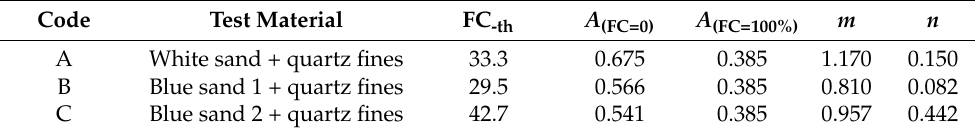
Figure 11. The relationship between the tested G max and evaluated G max by the revised model in the study. Table 3. The fitted parameters by the revised Hardin model of Payan et al.